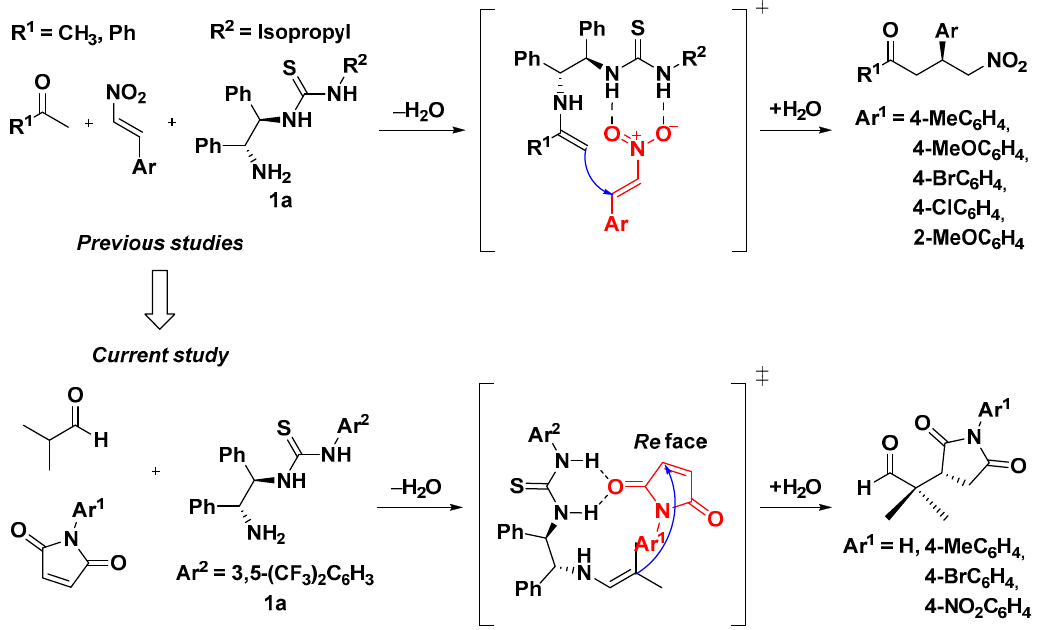
Figure 1. Mechanism of the Michael reaction using a non-covalent organocatalyst in aqueous media.